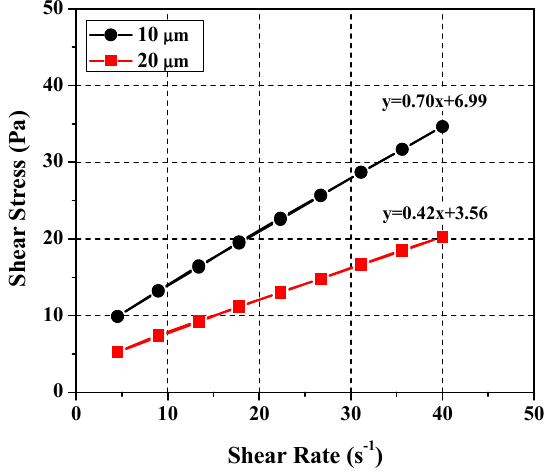
Figure 6. Test results of rheology for particle sizes.